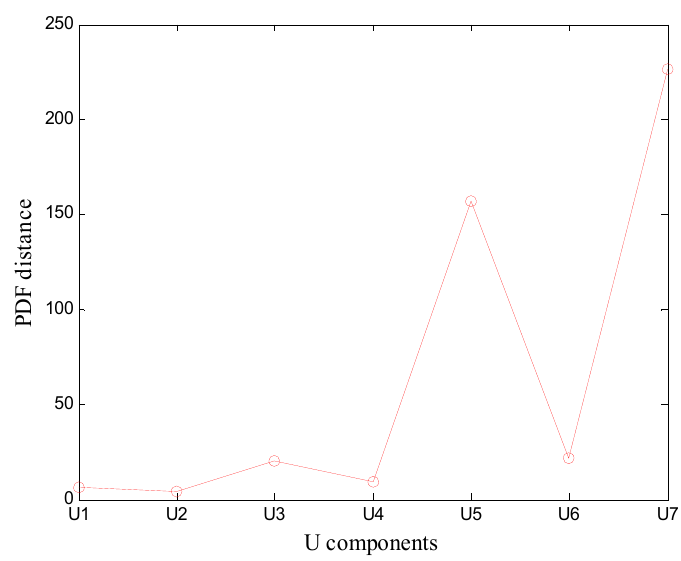
Figure 8. PDF distance between U components and the 1 mm leak signal.